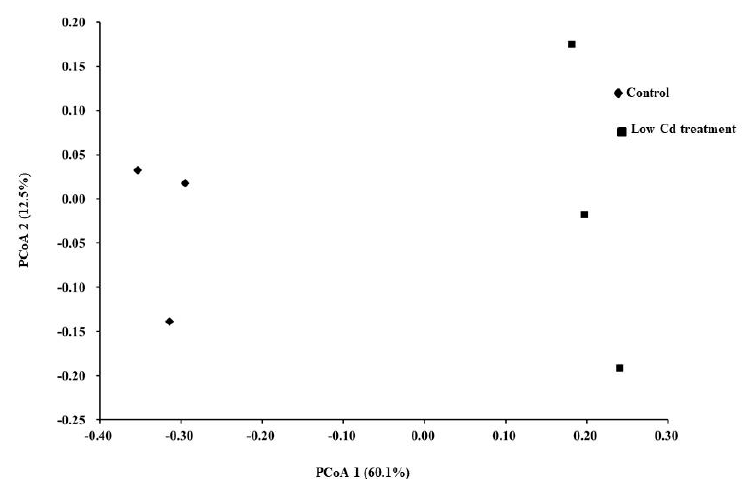
Figure 2. The plot generated by the weighted UniFrac-based PCoA.